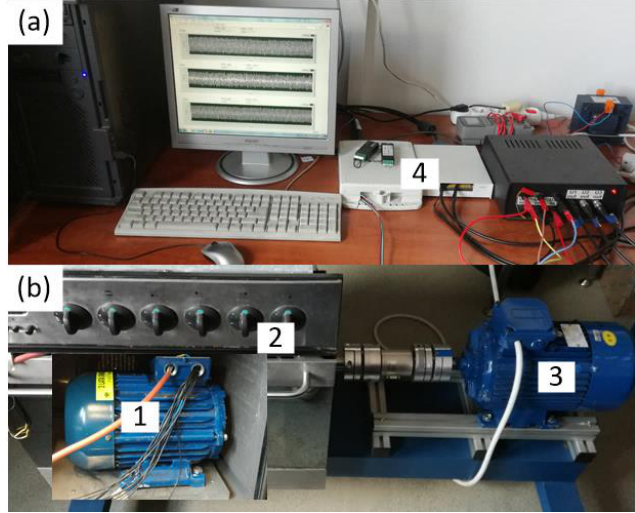
Figure 4. Test stand: ( a ) measuring apparatus, ( b ) BEMF (back electromotive force) test stand where 1 – LSPMSM motor, 2 – thermal chamber, 3 – driving motor, 4 – NI devices.